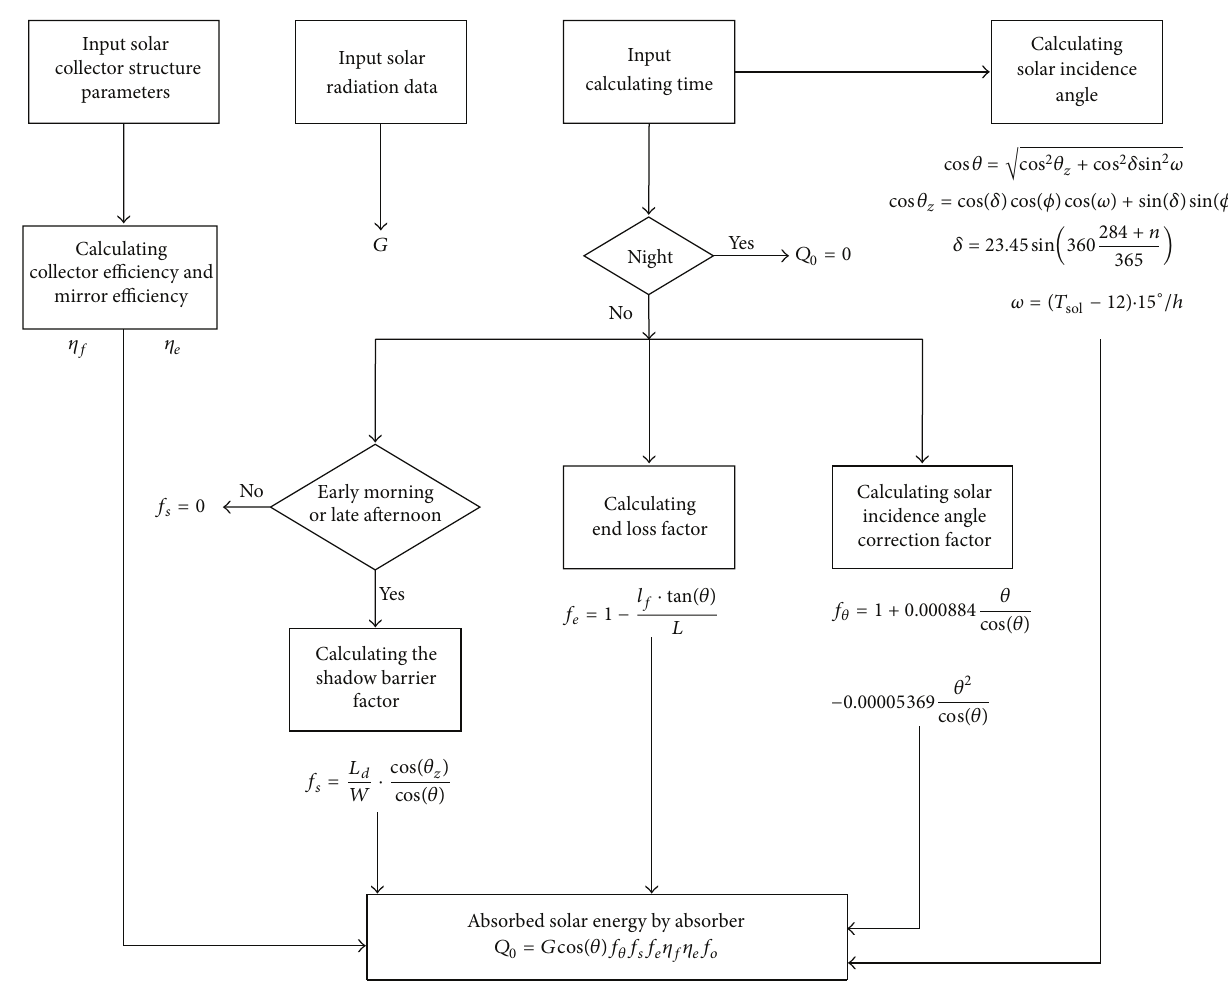
Figure 3: The schematic flow chart of the program to calculate the absorbed heat by